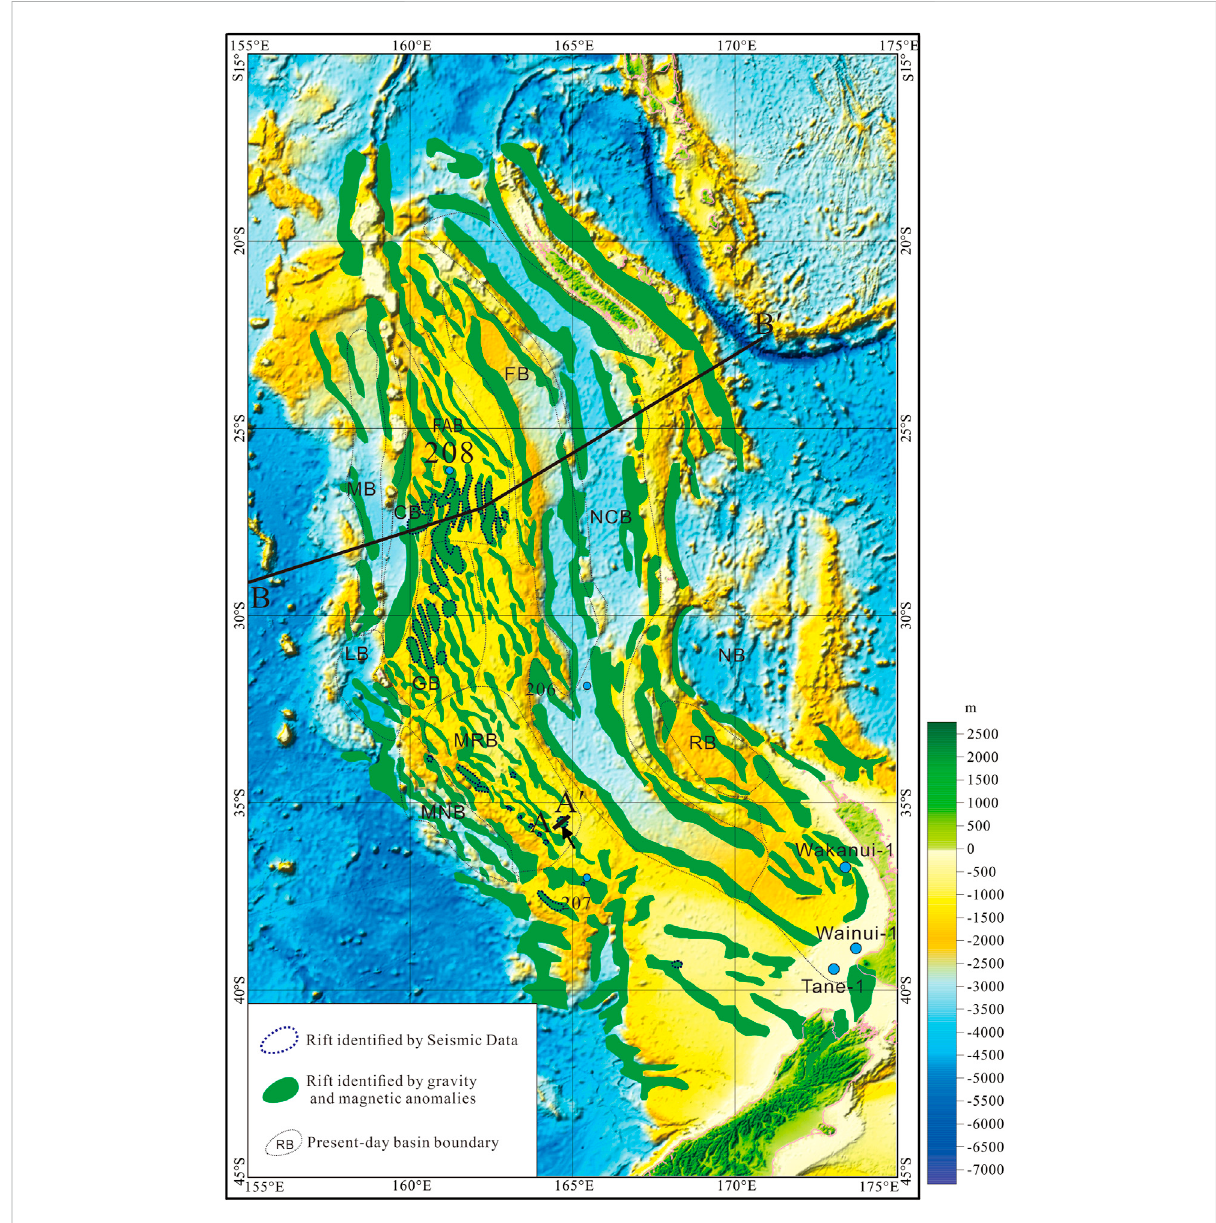
FIGURE 5 Identi fi ed rift distribution and its location